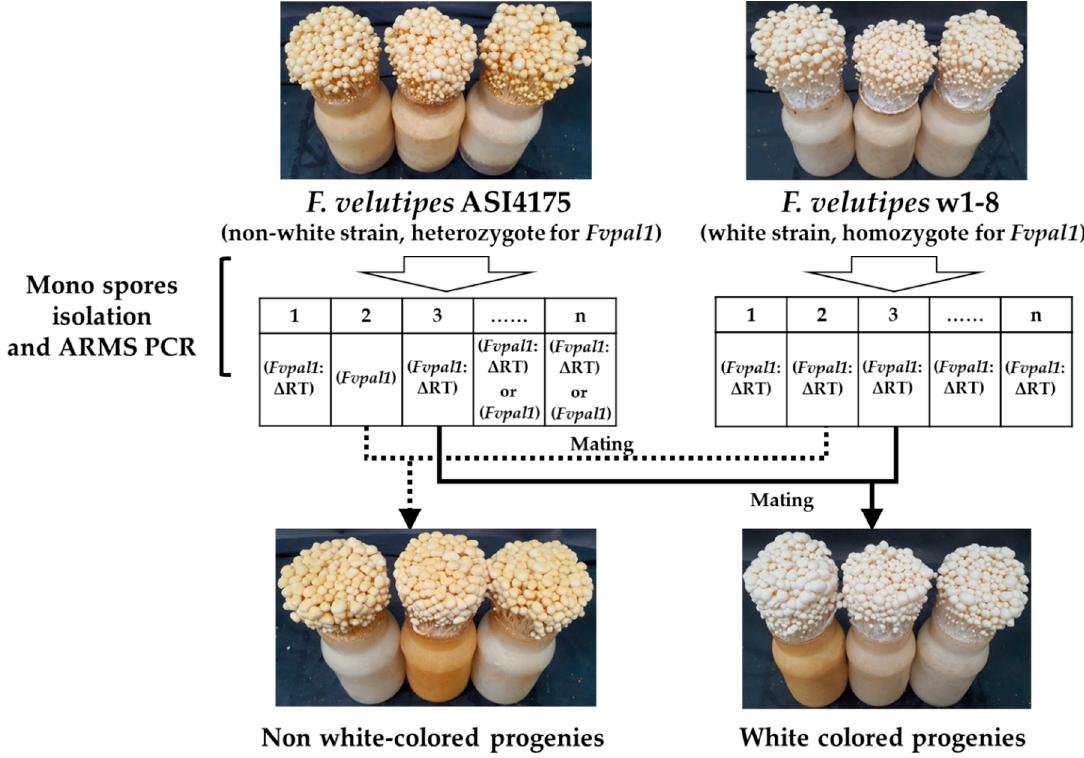
Figure 5. Matings of monospores from Flammulina velutipes strains ASI4175 (non-white, heterozygote) and w1-8 (white, homozygote). The isolated monospores were analyzed for the deletion of arginine and threonine; ∆ 112 RT 113 in the Fvpal1 gene using ARMS PCR. The number in the box indicates the isolated monospore.